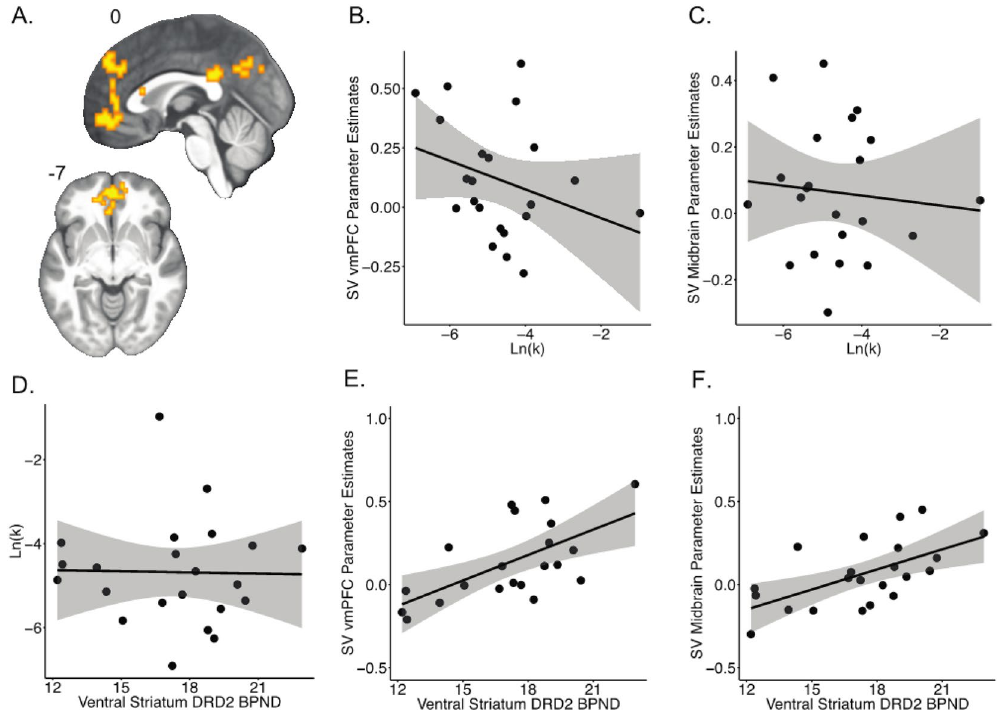
Figure 2. ( A ) Mean effect of subjective value ( N = 21) overlaid on the mean participant T1-weighted image in standard space, whole brain cluster-forming threshold Z > 2.3, cluster-corrected p < 0.05. Delay discounting was not correlated with the effect of subjective value on fMRI signal in the ( B ) vmPFC (N = 22, r = − 0.312, p = 0.158) or ( C ) midbrain (N = 22, r = − 0.097, p = 0.669). DA D2-like receptor availability in the ventral striatum was not correlated with ( D ) delay discounting (N = 22, r = − 0.053, p = 0.821). DA D2-like receptor availability was positively correlated with the effect of subjective value on fMRI signal in the ( E ) vmPFC (N = 21, r = 0.624, p = 0.003) and ( F ) midbrain (N = 22, r = 0.597, p = 0.003). Shaded regions indicate 95% confidence interval.